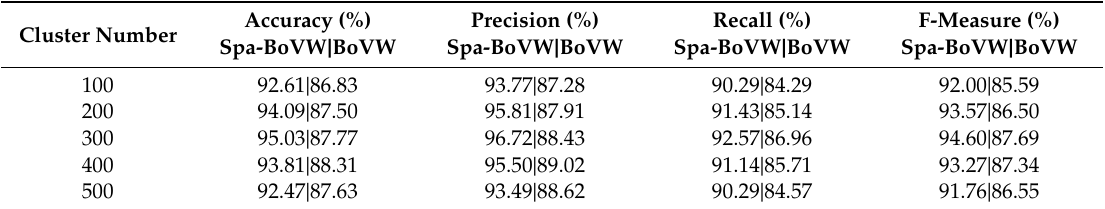
Table 6. Performance of Spa-BoVW vs. BoVW at detecting pornographic websites.